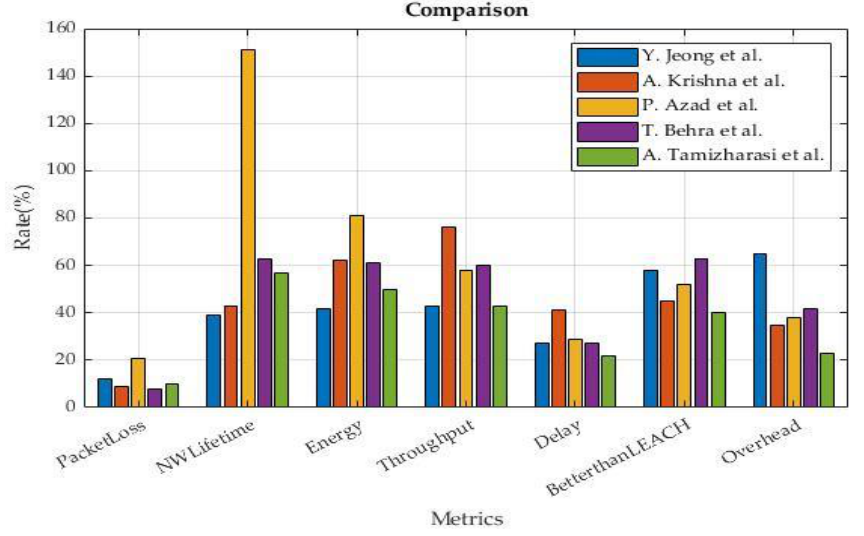
Figure 5. WSNs performance comparison based on recently reviewed articles.